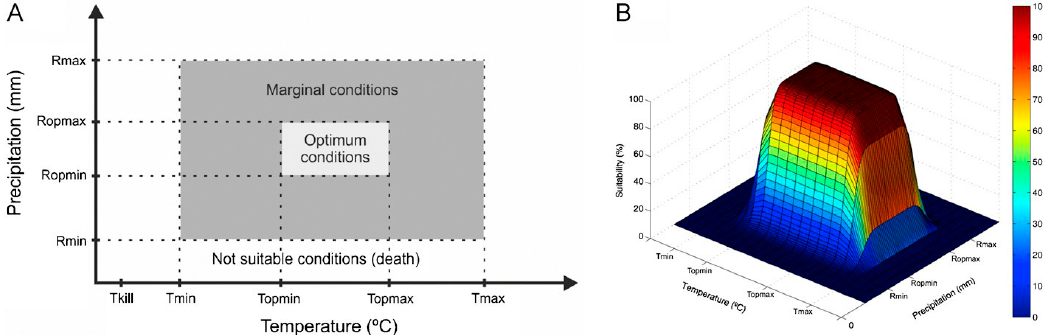
Figure 2. (a) two dimensional and (b) three dimensional diagram describing climate thresholds and its translation into crop suitability (Adapted from [50]). translation into crop suitability (Adapted from